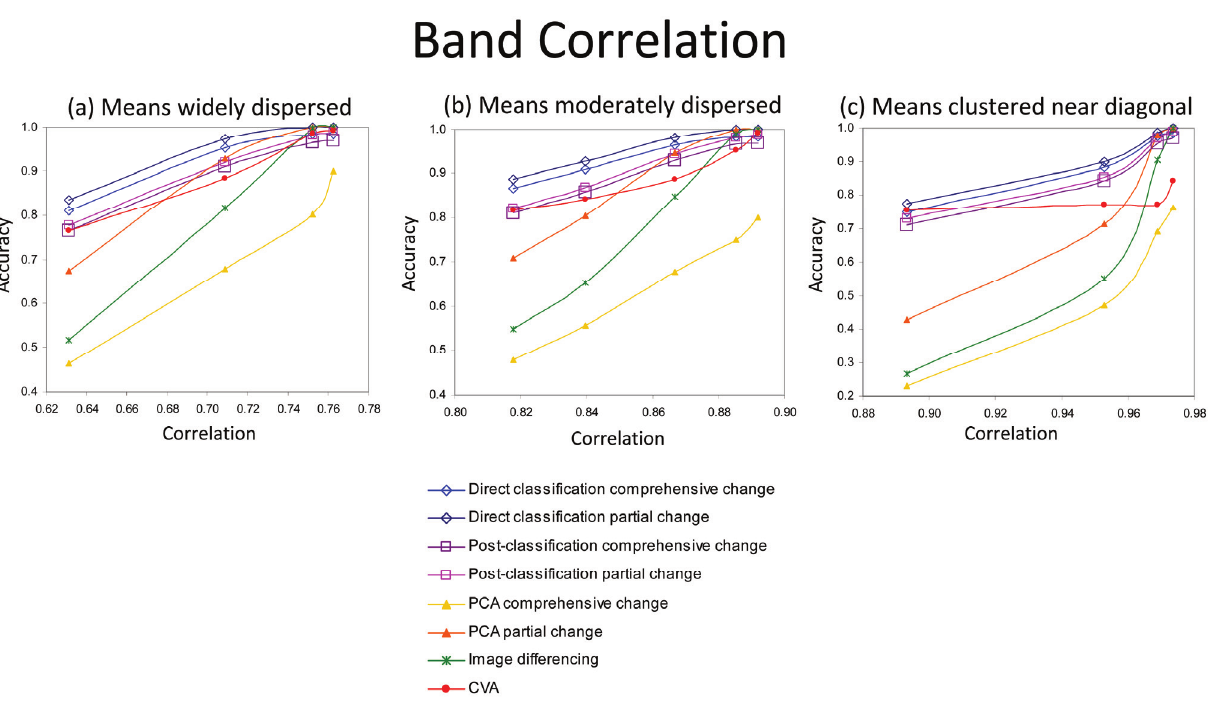
Figure 8. Effect of between band correlation on accuracy of change analysis methods, for simulated data with means widely dispersed in the spectral data space, means moderately dispersed, and means clustered near the